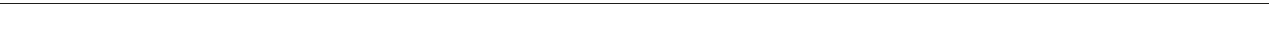
Fig. 3 MON2-DOPEY2 complex is required for SNX3-retromer-mediated sorting of Wls. a RNAi-mediated suppression of VPS35, SNX3, SNX1 and SNX2, or SNX27 in RPE-1 cells stably expressing HA-WLS and quanti fi cation of HA-WLS levels. b Inhibition of lysosomal degradation through Ba fi lomycin A1 treatment (100 nM for 16 h) restored total protein levels of HA-WLS following RNAi-mediated suppression of VPS35 or SNX3. c RNAi-mediated suppression of VPS35, DOPEY1, DOPEY2, DOPEY1 + DOPEY2 or MON2 reveals that the total protein levels of HA-WLS is dependent on the function of VPS35 and MON2. d Ba fi lomycin A1 treatment (100 nM for 16 h), inhibiting lysosomal degradation, prevents loss of HA-WLS protein levels following VPS35 and MON2 suppression using RNAi. a – d Data presented as mean + / − s.e.m. from three independent biological replicates. Signi fi cance was determined using a one-way ANOVA with a post-hoc Dunnett ’ s test; * p < 0.05. e Representative western blot of endogenously expressed MIG-14::GFP ( huSi2 ) protein levels in animals treated with control, vps-35 , mon-2 or pad-1 RNAi. f Confocal imaging of MIG-14::GFP (green, huIs72 ) and the late endosomal and lysosomal marker LMP-1::mCherry (red, huEx149) in L1 larvae. The tail area, which includes the EGL-20 producing cells, is shown. Arrows indicate regions of colocalization. In all images, anterior is left and dorsal is up. Scale bar is 10 µ m. g Staining of EGL-20::protA with rabbit-anti-goat- Alexa647 in L1 larvae. The EGL-20 producing cells are indicated with a solid line, the punctate gradient that is formed by EGL-20::protA is indicated with a dashed line. In all images, anterior is left and dorsal is up. Scale bar is 10 µ m. h Systemic knock down of mon-2 or pad-1 interferes with the EGL-20/Wnt dependent posterior migration of the QL descendants (QL.d) in a vps-29(tm1320) sensitised genetic background. The percentage of animals with anteriorly displaced QL.d is shown (data are presented as mean + / − SD and include results from four independent biological replicates, with n ≥ 25 per replicate) * p